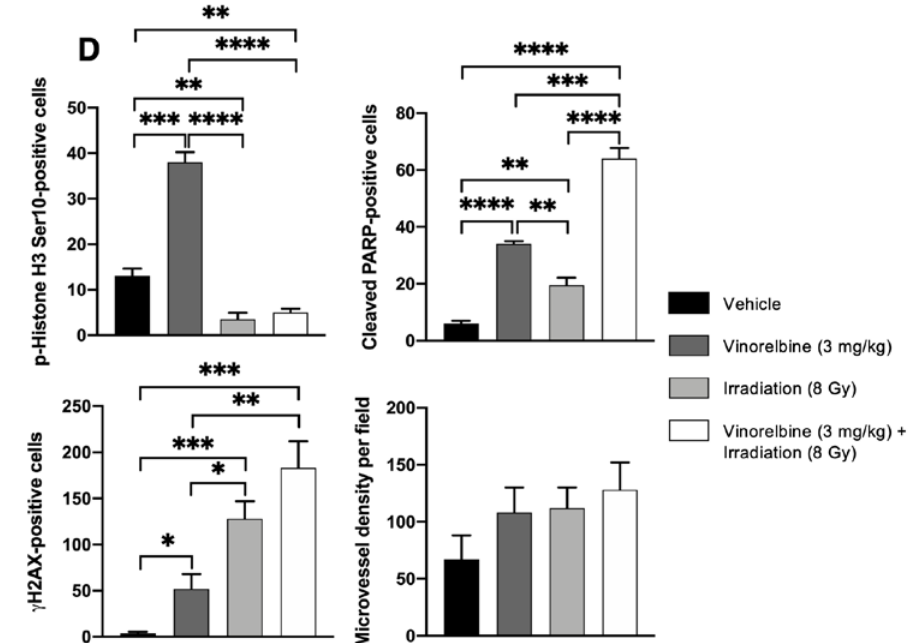
Figure 3. E ff ects of localized RT, Vinorelbine, and RT / Vinorelbine on tumor growth of the HCC models. HCC19-0913 or HCC09-0913 tumors were subcutaneously implanted on both flanks and treated with vehicle, Vinorelbine, 8 Gy irradiation, or the combination of both as described in the Materials and Methods section. For irradiated mice, tumors on the right flanks were locally irradiated with 8 Gy, and the left flank tumor served as an internal control. Mean tumor volumes ± SE over time are shown ( A , B ). Immunohistological analysis of tumors stained with CD31, p-Histone H3 Ser10, cleaved PARP, and γ H2AX as described in Appendix A ( C ). Representative images are shown. For p-Histone H3 Ser10, cleaved PARP, and γ H2AX, the number of staining-positive cells among at least 500 cells per region was counted, as described in the Supplementary Materials and Methods sections, and is expressed as the number of positive cells per 1000 cells ± SE. For quantification of mean microvessel density, five random fields at a magnification of × 100 were selected for each section. The mean number of CD31-positive blood vessels per field was counted and expressed as ± SE ( D ). * p < 0.05; ** p < 0.01; *** p < 0.001; **** p < 0.0001, Student’s t -test.